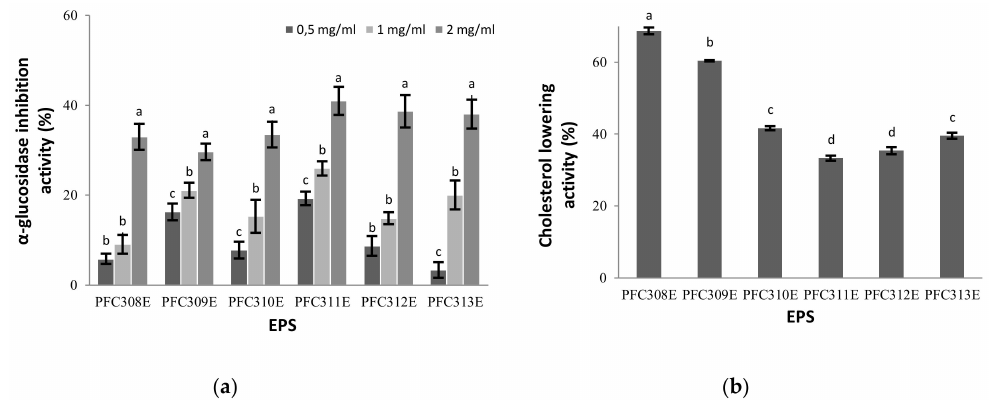
Figure 4. The ( a ) α -glucosidase inhibitory and ( b ) cholesterol lowering activities of ropy EPS at di ff erent concentrations. Di ff erent letters show the di ff erences ( p < 0.05) between the concentrations at each EPS at ( a ) and EPS at ( b